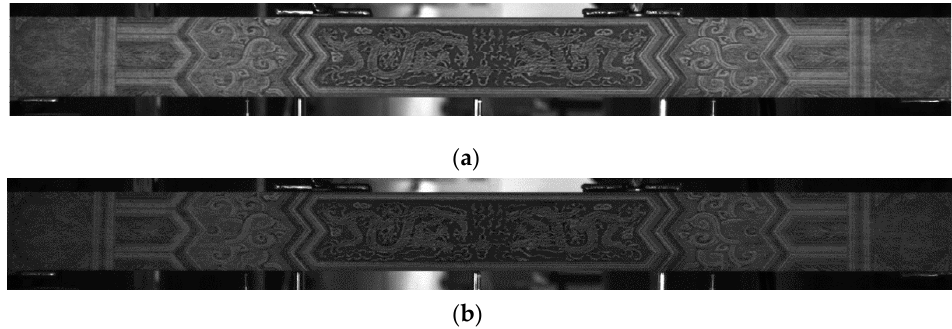
Figure 13. Grayscale images of the painting beam: ( a ) light group; ( b ) dark group.